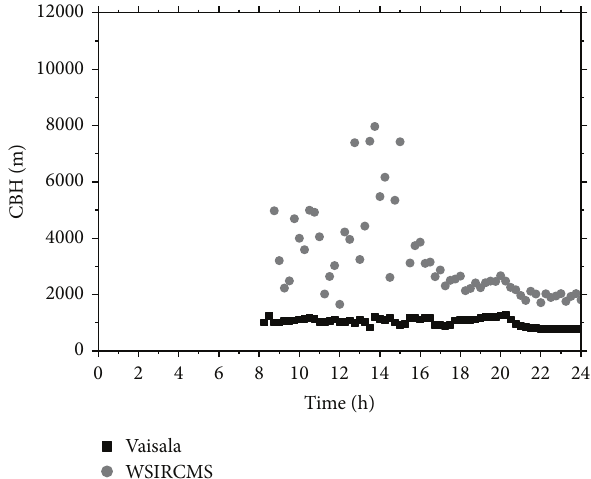
Figure 7: The 6 January 2012 case: CBH values as determined by WSIRCMS (grey circle) and Vaisala CL51 (black